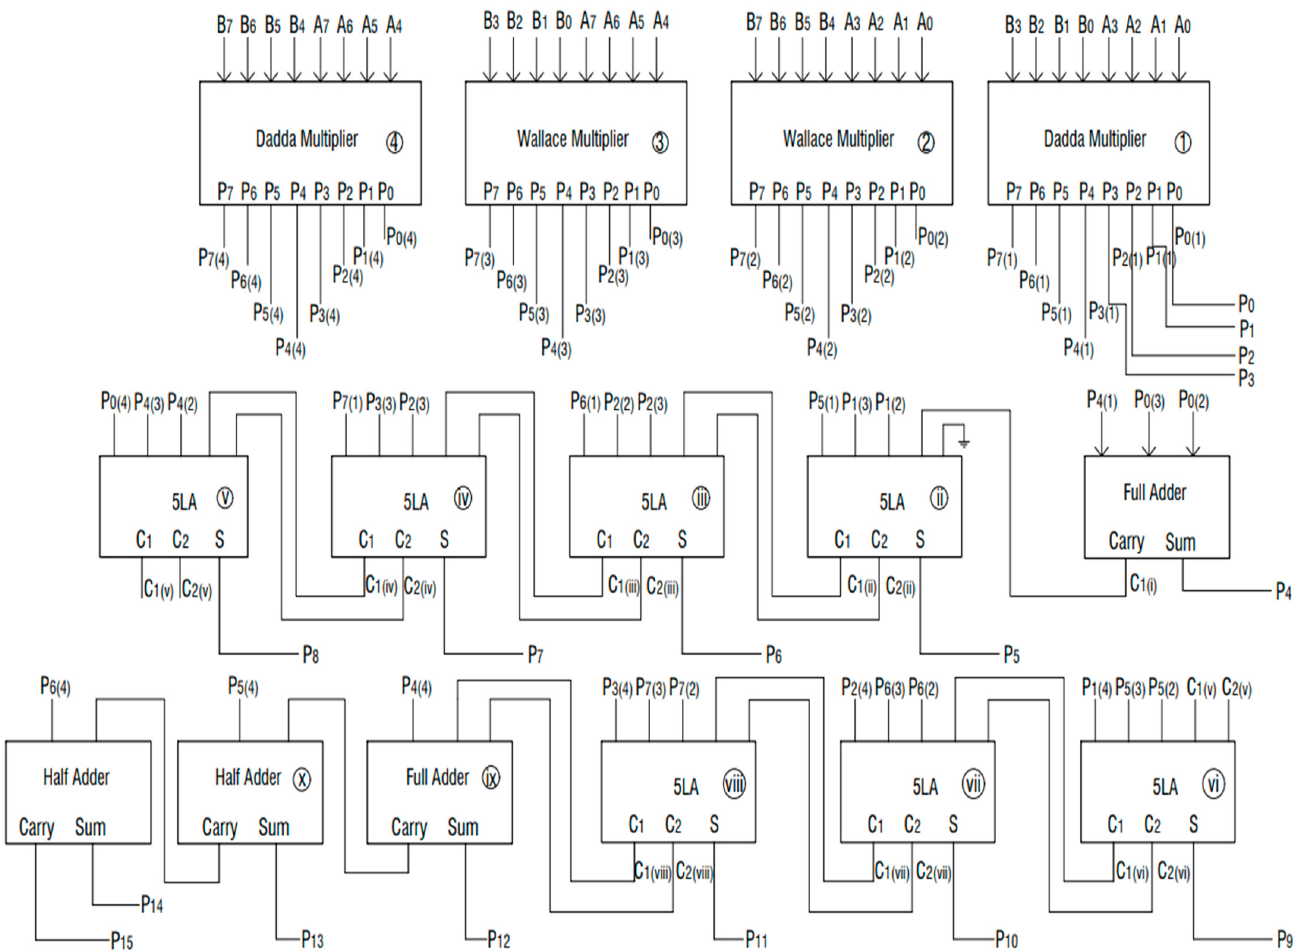
Figure 5. Schematic design of 8 × 8 GD multiplier.